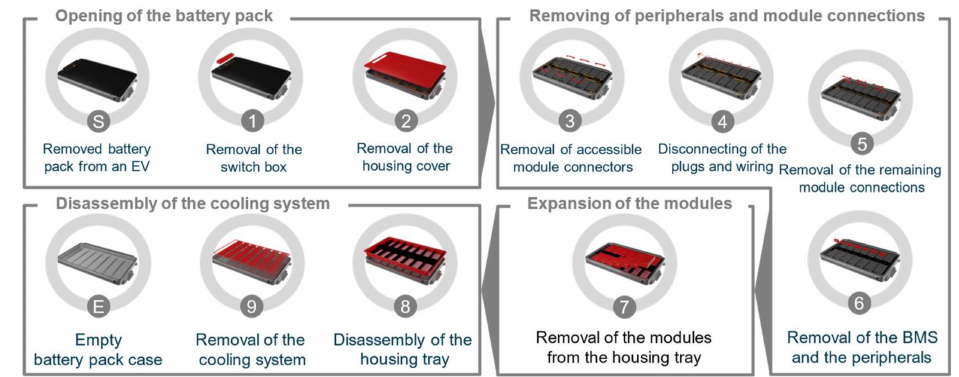
Figure 3. Simplified representation of the disassembly process of a typical state of the art lithium-ion battery